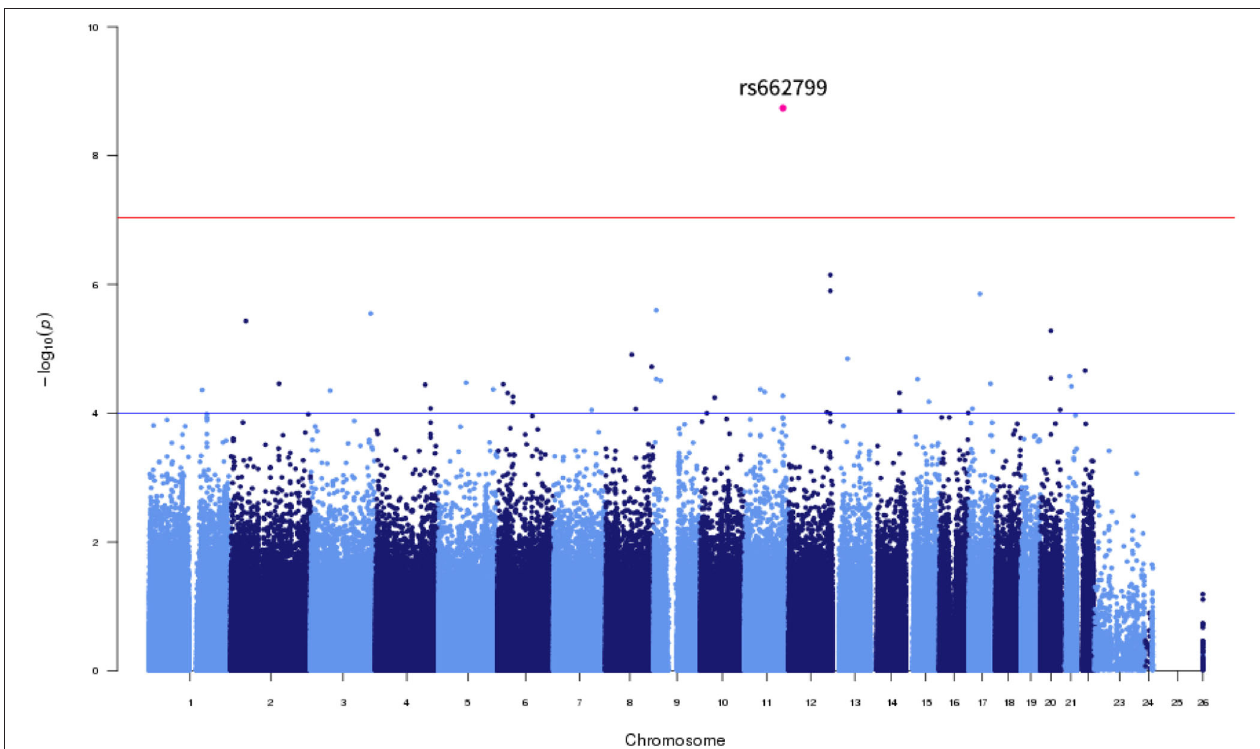
FIGURE 1 | Manhattan Plot for LDL cholesterol variability by